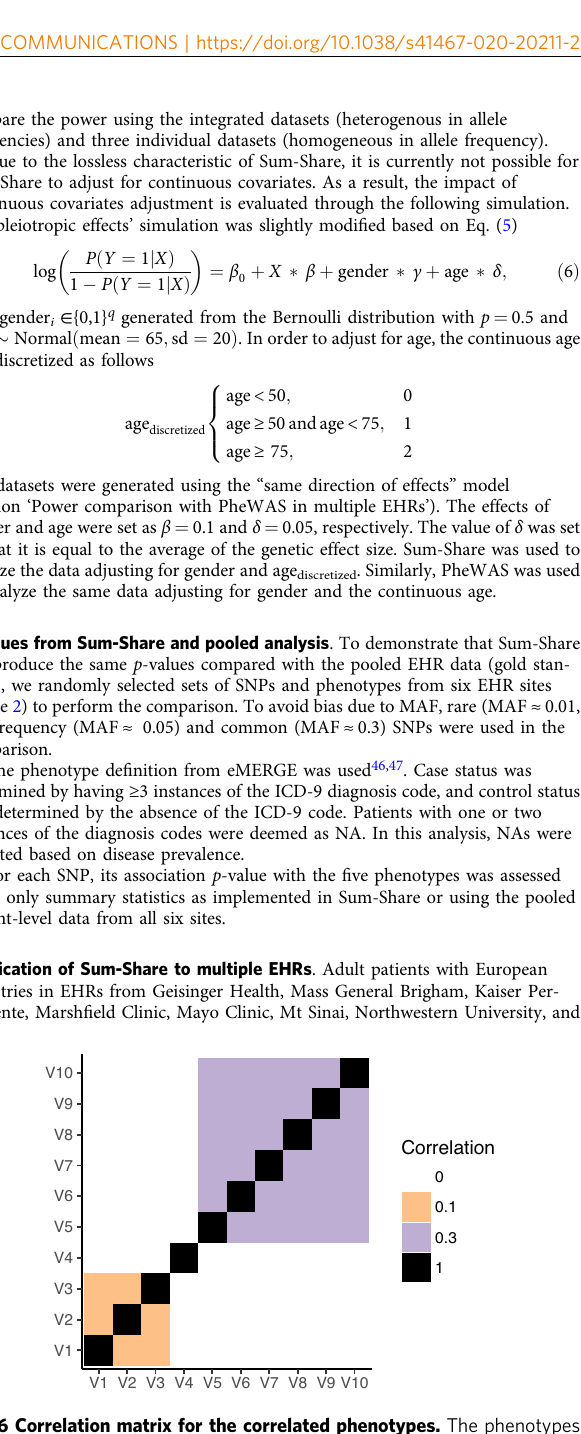
Fig. 6 Correlation matrix for the correlated phenotypes. The phenotypes were simulated to exhibit two correlated clusters. The phenotypes within each cluster are correlated with each other. Phenotypes outside of the cluster are not